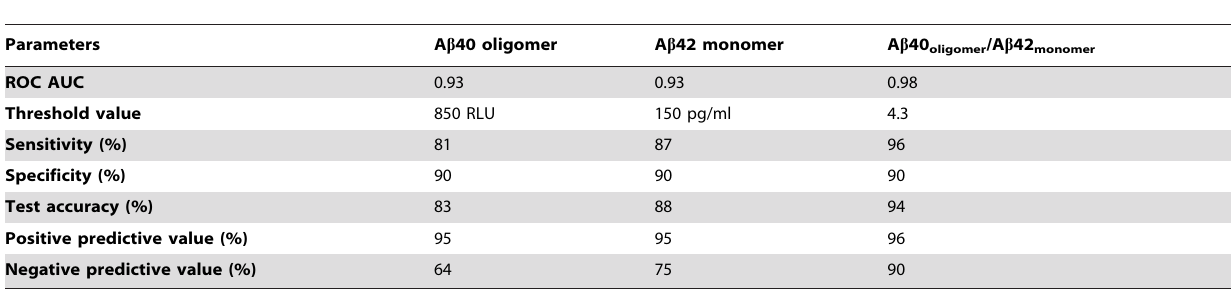
Table 1. ROC analysis and diagnostic performance for A b 40 oligomer, A b 42 monomer, and A b 40 oligomer /A b 42 monomer biomarkers.